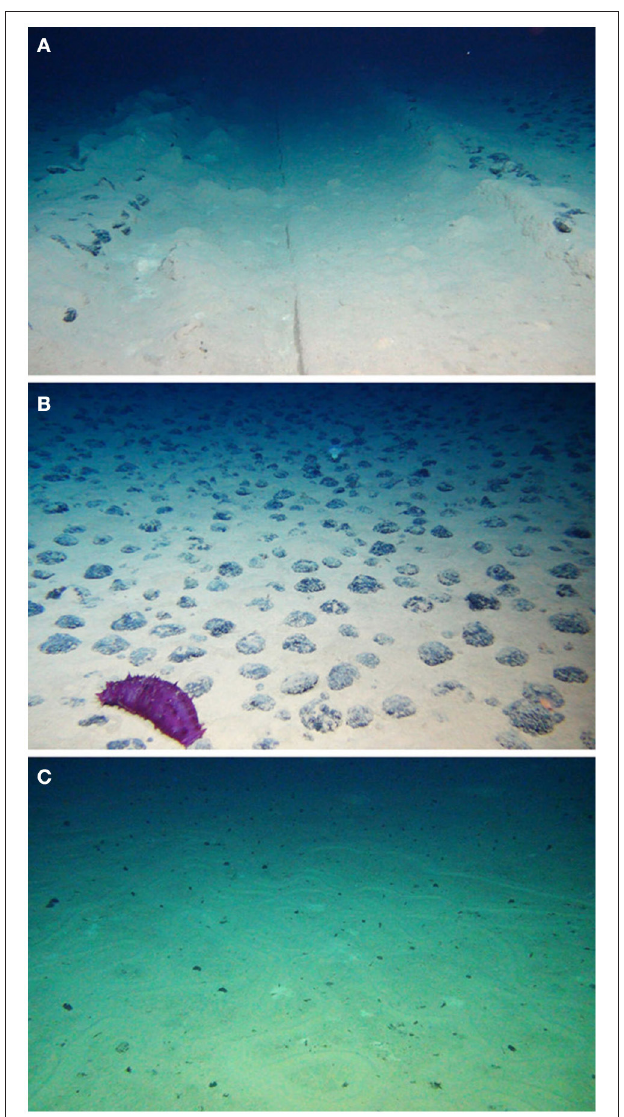
FIGURE 6 | Examples of seafloor morphology and disturbance. (A) Thirty-seven year old OMCO track (IFREMER license area); (B) Nodule landscape (IFREMER license area); (C) Nodule-free landscape (IOM area). Copyright: ROV Kiel 6000 Team/GEOMAR Kiel, EcoResponse cruise with RV Sonne, April–March